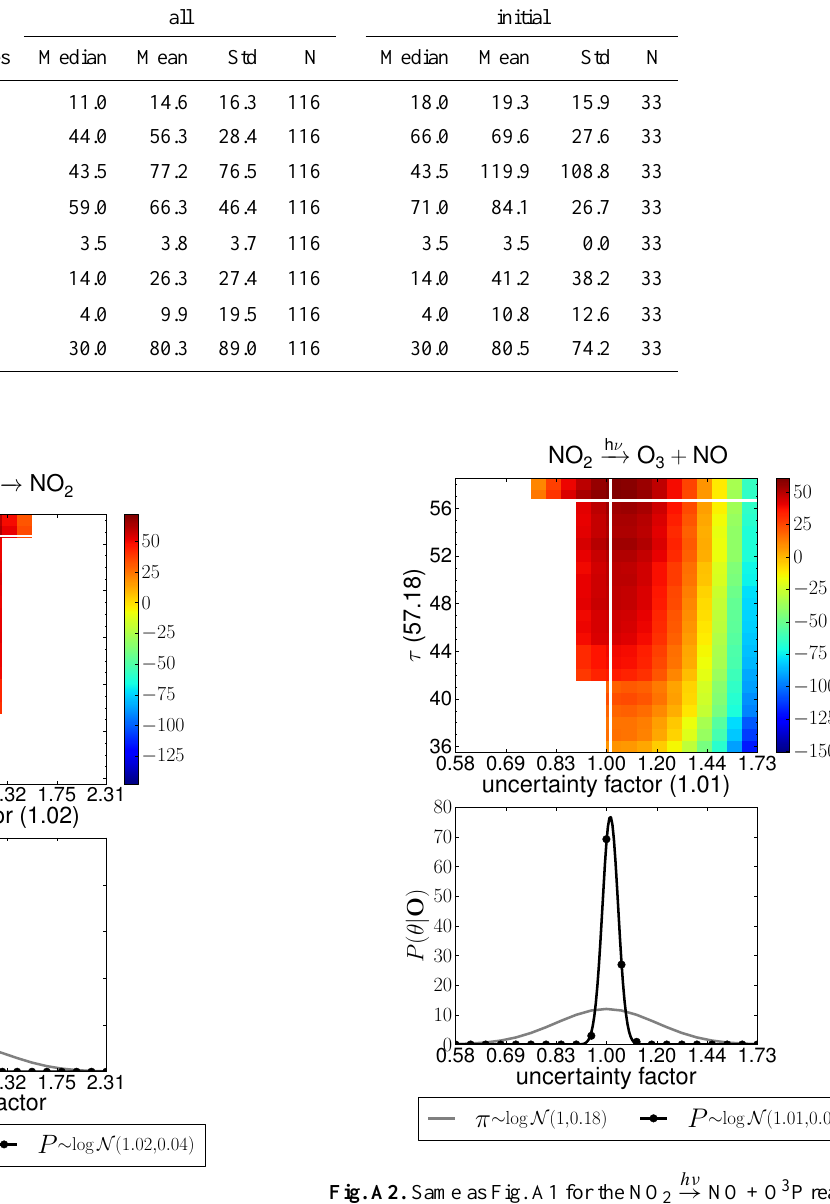
Fig. A1. Posterior distribution in two dimensions (color plot) and integrated for all tested τ valus (line plot) for the NO+O 3 → NO 2 +O 2 reaction. The two dimensional posterior distribution as a function of uncertainty in the rate and time-since-convection ( τ ). On the two-dimensional posterior plots, the inferred values of τ and the reaction rate scaling factor are in parentheses. The one dimensional posterior distribution is as a function of the reaction rate uncertainty. On the one-dimensional posterior plot, the line is a smoothed uncertainty using the inferred estimate and standard deviation to construct a log-normal uncertainty. When the log-posterior is white, it was incalculably small ( −∞ ). Figure continues on next page.